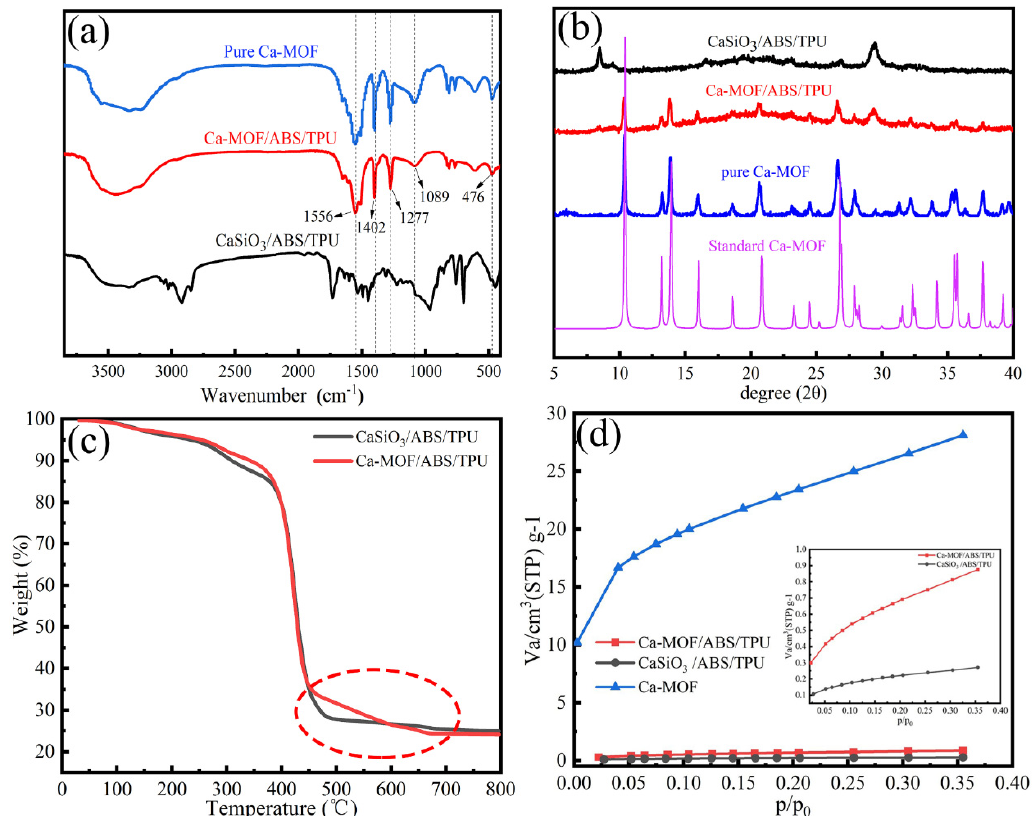
Figure 5. ( a ) FTIR spectra, ( b ) XRD patterns, and ( d ) N 2 adsorption isotherms of CaSiO 3 / ABS / TPU, Ca-MOF / ABS / TPU and pure Ca-MOF, ( c ) TG curves of CaSiO 3 / ABS / TPU and Ca-MOF / ABS / TPU.